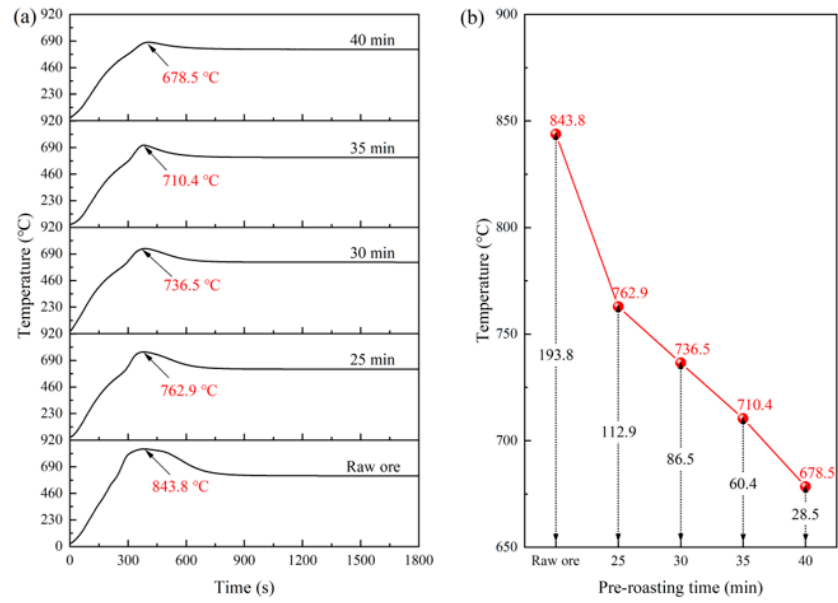
Figure 5. ( a ) The internal temperature change process of materials during roasting, and ( b ) the comparison between the internal peak temperature of materials and the preset roasting temperature.